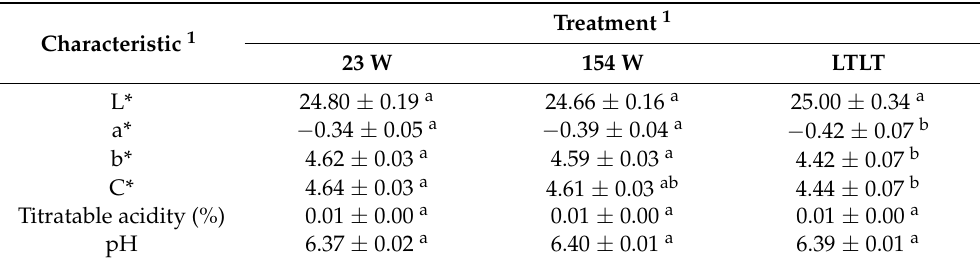
Table 1. Effect of ultrasound power and pasteurization on physicochemical characteristics of whey– oat